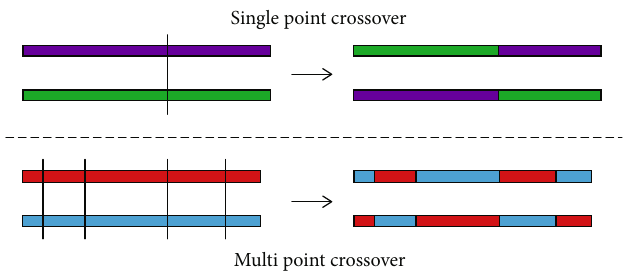
Figure 2: Crossover operator under binary